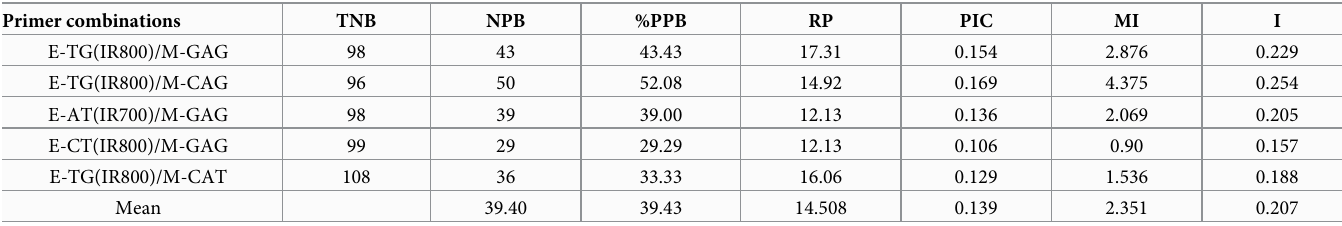
Table 1. Variability parameters for five AFLP primer combinations.